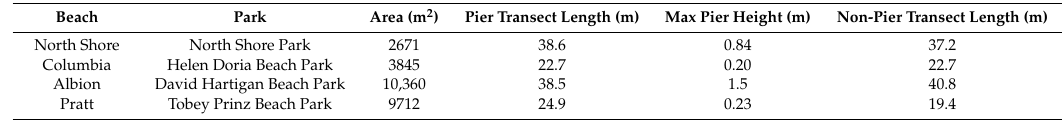
Table 1. Characteristics of study sites and